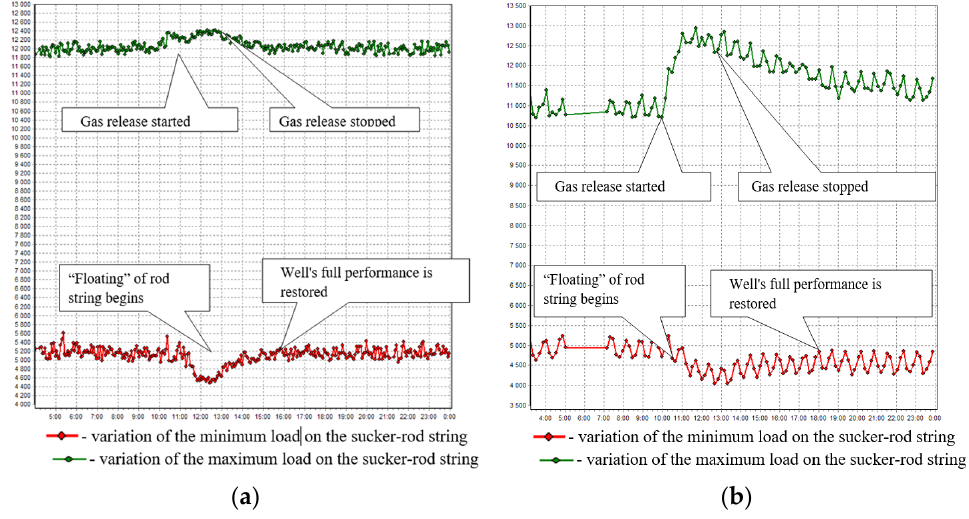
Figure 5. Variation trends of maximum and minimum loads on the sucker-rod string during annular gas extraction. ( a ) at the well No. 14764d; ( b ) at the well No. 3963. At the well No.5597d, after the gas was extracted from the annulus, the viscosity in- creased significantly from 20 mPa-s to 330 mPa-s, the ARPS content in oil increased from 3.3% to 12.1% (Figure 6). The viscosity variations of the produced fluid after recovery of annular gas are not that evident at all wells due to emulsion breakdown while samples are being transported to the laboratory.